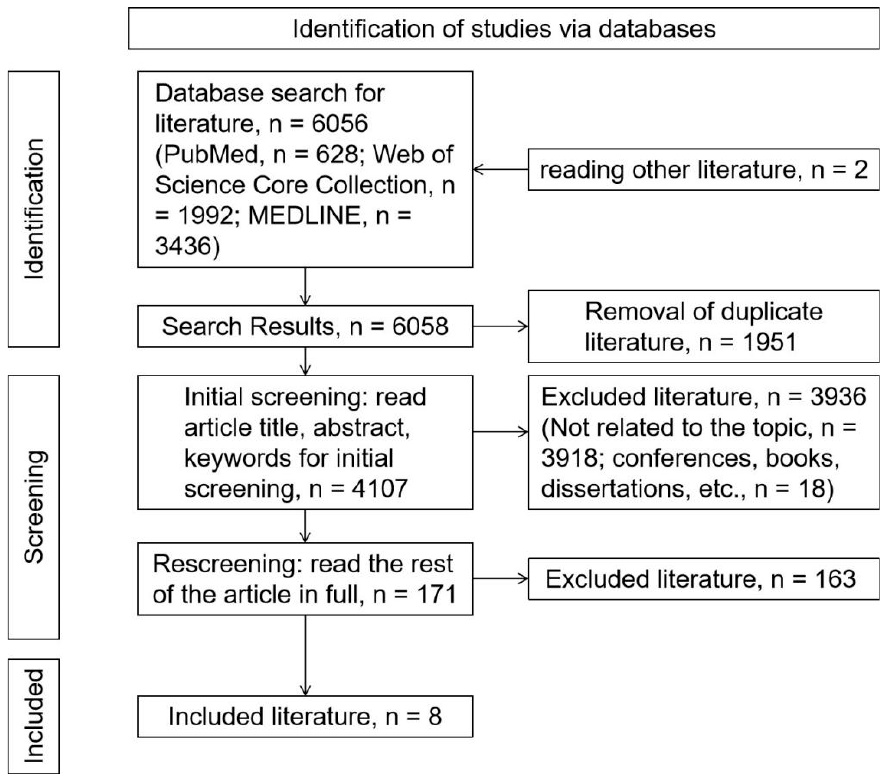
Figure 1. The literature search process.